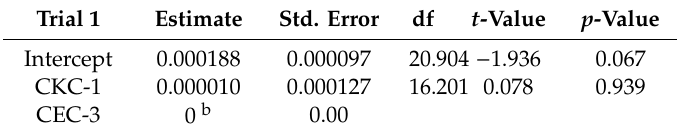
Table 17. The significant di ff erence of the mean of VR obtained in Trial 1 between CKC-1 and CEC-3. Trial 1 Estimate Std. Error df t -Value p -Value Intercept 0.000188